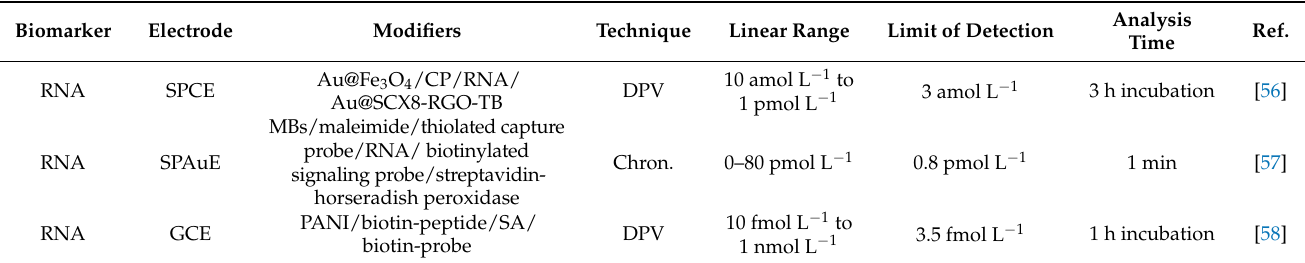
Table 3. Summary of electrochemical genosensors for SARS-CoV-2